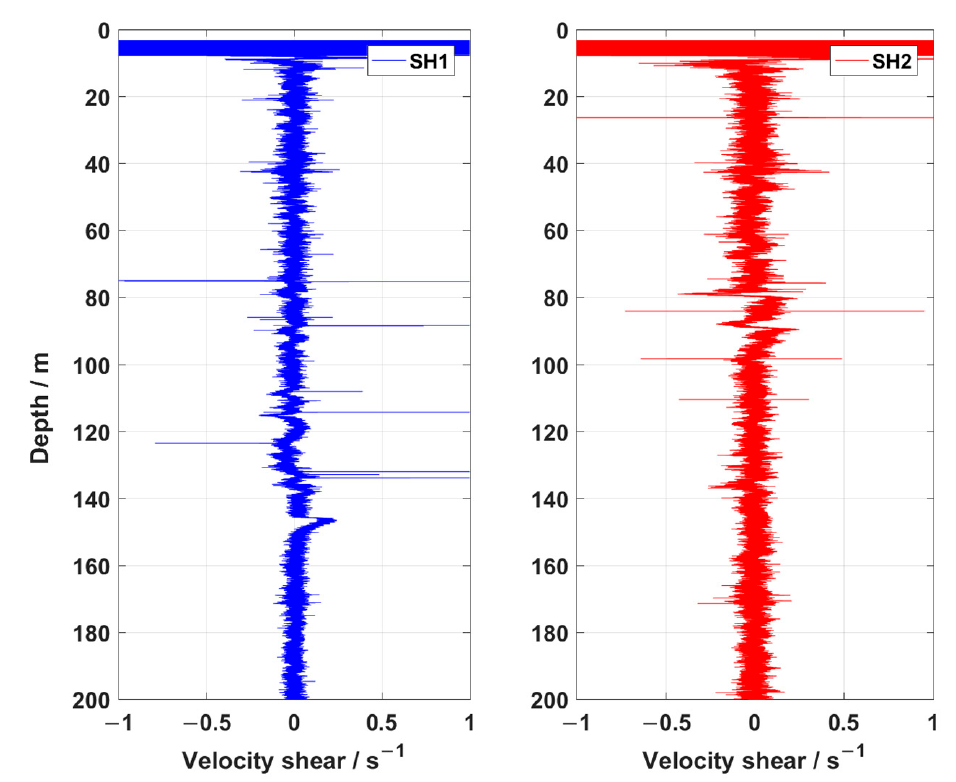
Figure 7. Sample of velocity shear of the two shear probes (SH1, SH2), collected during a steady descent of the fifth profile.